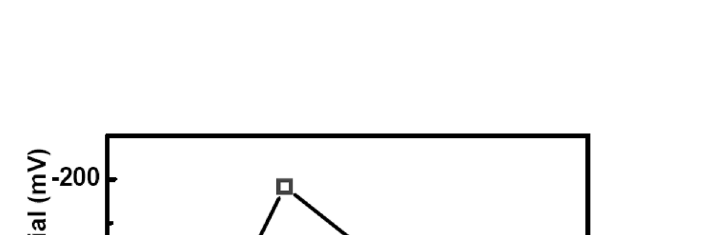
Figure 2. Image taken by SEM and TEM instrument ( a ) photographs of PAN nanofiber paper with 30 wt% Pt loading after stabilisation (brown) and after carbonisation at 800 °C (black). ( b ) An SEM image of unhydrolyzed Pt-loaded carbonised nanofiber with Pt aggregates (white spots); the inset shows SEM and TEM images of an individual Pt-loaded nanofiber. ( c ) An SEM image of a Pt-loaded carbonised nanofiber subjected to hydrolysis at 50 °C; SEM and TEM images for 30 wt% Pt-loaded nanofiber (top and middle panels in the inset) are also shown along with a TEM image for 40 wt% Pt-loaded nanofiber (bottom inset). ( d ) High-resolution TEM images of samples with 30 wt% Pt loading. The surface morphology were observed by using a scanning electron microscope (SEM; JSM6700F, ZEOL) and a transmission electron microscope (TEM; JEM2100F, ZEOL).